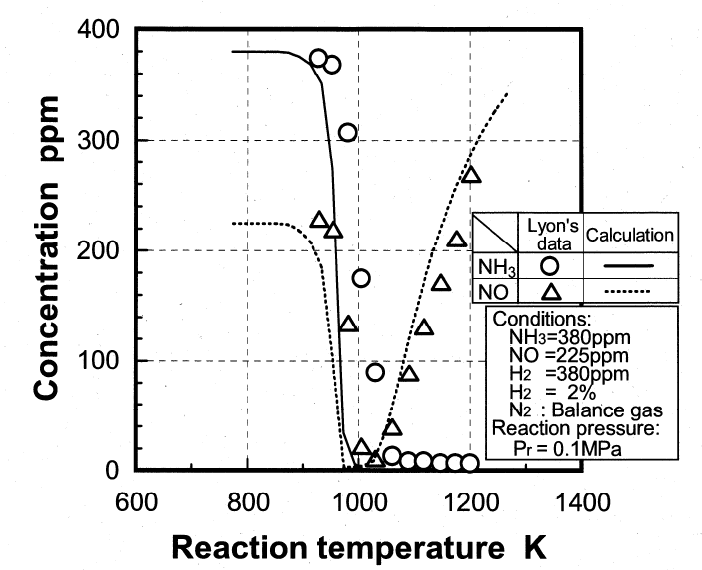
Figure 28. Comparison of model prediction with the experimental data of Lyon [74.]